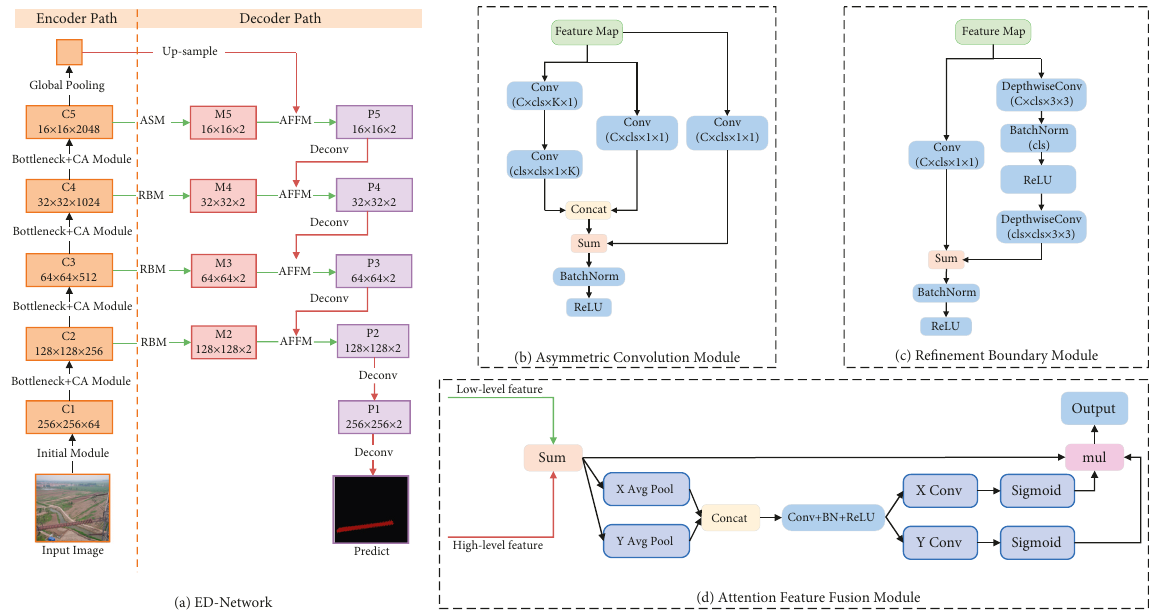
Figure 2: Overview of proposed ED-Net architecture (a). It consists of two parts: Encoder path and Decoder path. The feature maps of C1, C2, C3, C4, and C5 are obtained by the Initial Module (IM) and Bottleneck +CA Module. M2, M3, M4, and M5 are the feature maps of the encoder path obtained through Asymmetric Convolution Module (ASM) or Refinement Boundary Module (RBM). P1–P5 are obtained by the Attention Feature Fusion Module (AFFM), and P1 is used for insulator segmentation. The details of ASM, RBM, and AFFM are illustrated in (b), (c), and (d), respectively. The red and black lines represent the upsample and downsample operations, respectively. The green line does not change the size of the feature map, only the number of